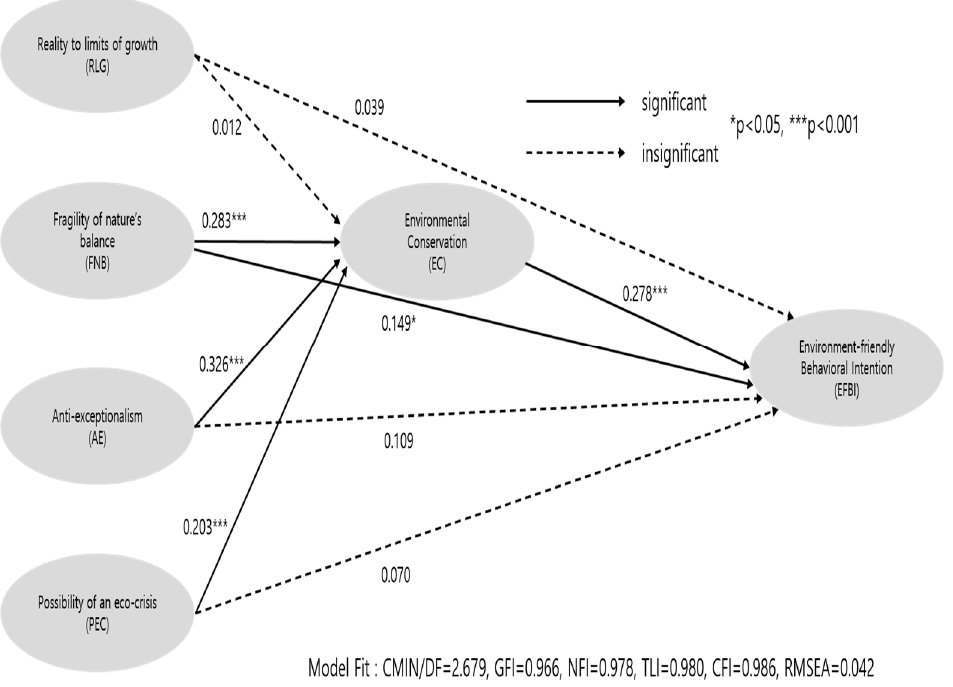
Figure 3. Structural equation model results.